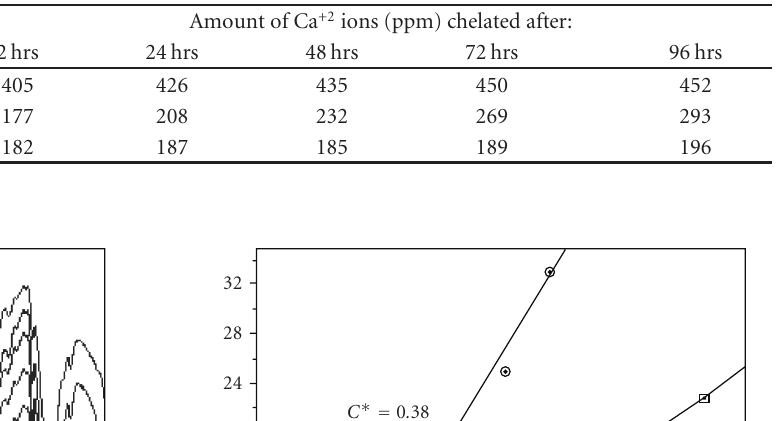
Figure 2: Depolymerization of chitosan by nitrous acid. Table 3: Chelation property of chitosan.